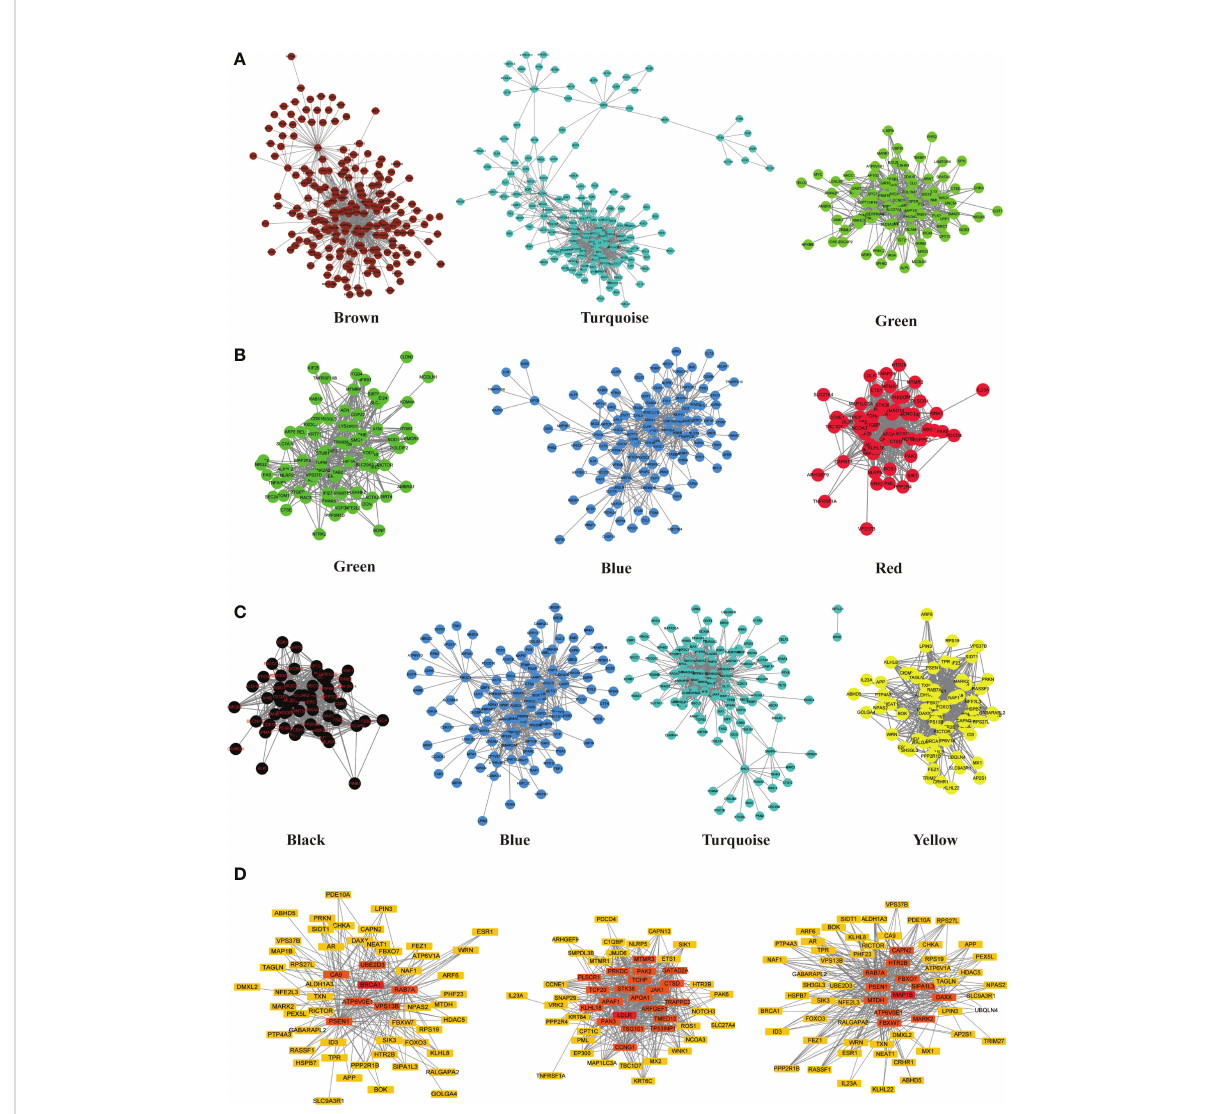
FIGURE 4 Co-expression network of PCOS-autophagy-related modules and core ATGs visualized by Cytoscape. (A – C) Sub-networks of key modules in GSE8157 (A) , GSE43264 (B) and GSE106724 (C) . Module networks extracted from WGCNA. The nodes represent genes. The interaction between each node was evaluated by adding an edge between them. The node ’ s color is in accordance with the color of the key modules. (D) Network analysis with the most correlations identi fi ed hub ATGs. The color scale of yellow to Red indicates differences in correlations. The closer the color to Red, the stronger the